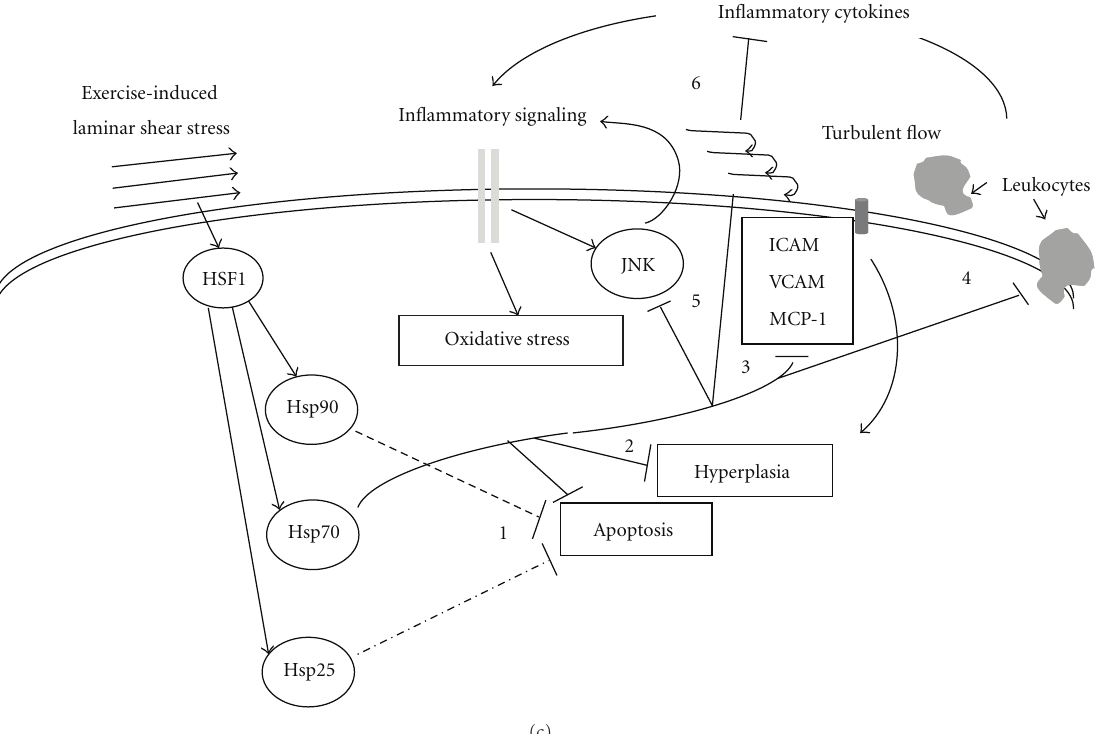
Figure 2: Scheme for relationships between exercise-associated hemodynamic changes, inflammatory response, and Hsp. (a) Low or turbulent flow is associated with leukocyte extravasation [1] and expression of adhesion molecules [2], resulting in intimal hyperplasia, cell apoptosis [3] and inflammatory signaling [4]. The associated inflammatory signaling leads to increased oxidative stress, induction of inflammatory pathways such as c-Jun NH 2 -terminal kinase (JNK) [5] and NF- κ B [6], and suppression of endothelial nitric oxide (eNOS) and oxidation of nitric oxide (NO) [7]. (b) In contrast, an exercise induced increase in laminar shear stress activates eNOS [1] and HSF1 [2]. HSF1 activation leads to increased heat shock proteins 25, 70, and 90 (Hsp25, Hsp70, and Hsp90) [3] which may inhibit many of these inflammatory processes indirectly via activation of eNOS signaling (Hsp90) [4] and directly through suppression of oxidative stress (Hsps 25, 70, and 90) [5] and inflammatory signaling including via the NF- κ B pathway (Hsps 25 and 70) [6]. (c) Hsp may also directly reduce apoptosis (Hsps 70 and 90) [1] and hyperplasia (Hsp 70) [2]. Hsp70 has further been implicated in decreased expression of adhesion molecules [3] leading to a reduction of leukocyte extravasation [4] and expression of inflammatory cytokines [6]. Hsp70 also suppresses JNK signaling [5] further inhibiting inflammatory signaling and cytokine release. See text for a more complete description. → — represents activating role; | — represents inhibitory role; ----: Hsp90 e ff ects; ——: Hsp70 e ff ects; - · - · - · - · : Hsp25 e ff